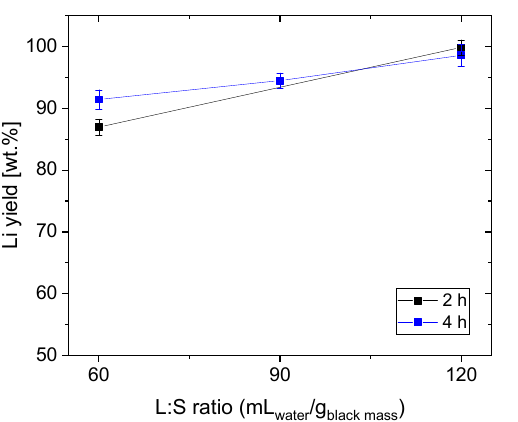
Figure 7. Effect of L:S ratio on the Li yield carrying out the COOL-Process at 230 °C for 2 or 4 h as residence time.